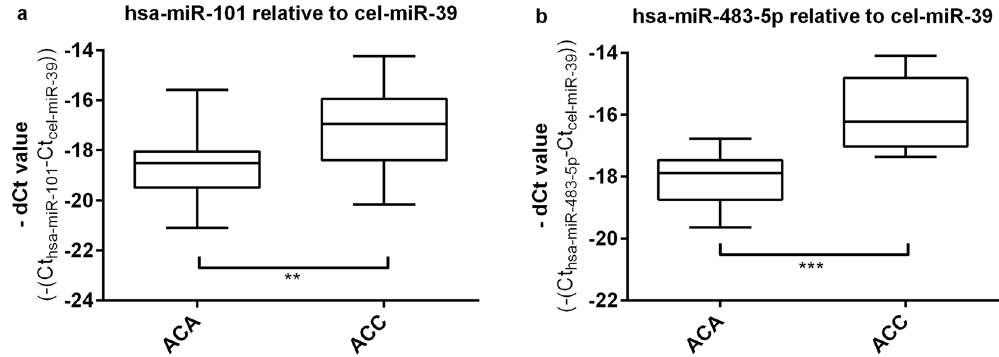
Figure 4. Results of RT-qPCR validation of hsa-miR-101 ( a ) and hsa-miR-483-5p ( b ) normalized to the housekeeping cel-miR-39 , (mean ± SD, ** p < 0.01, *** p < 0.001; unpaired t-test; n = 18 ACA, n = 16 ACC.